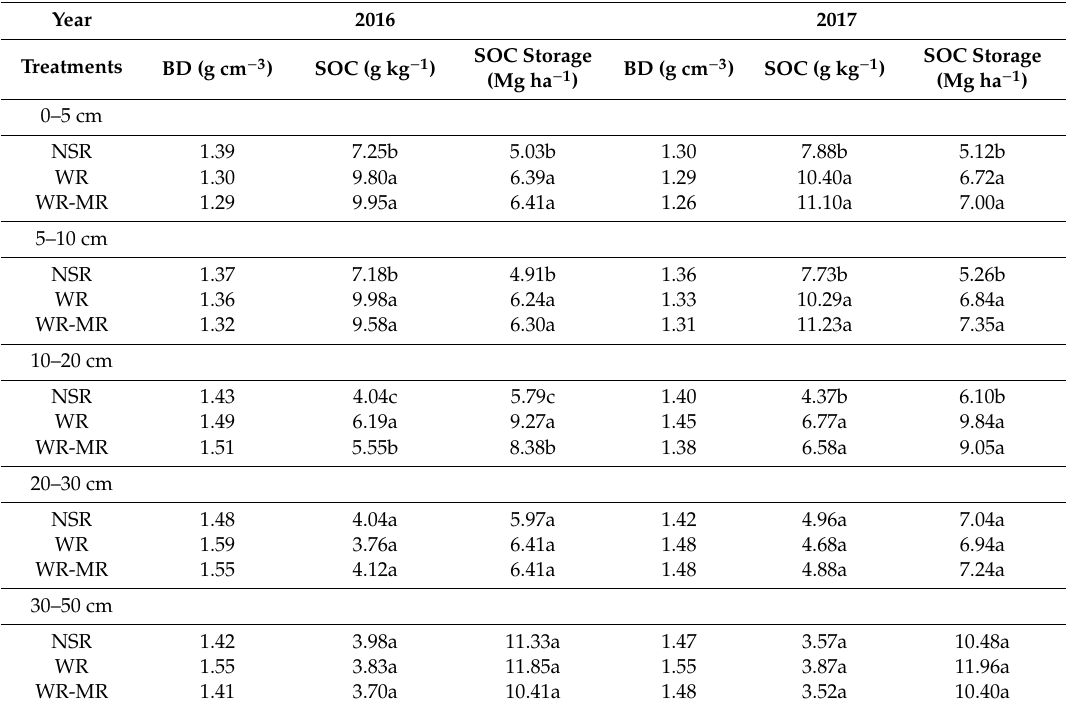
Table 2. The SOC concentration and storage under di ff erent straw return